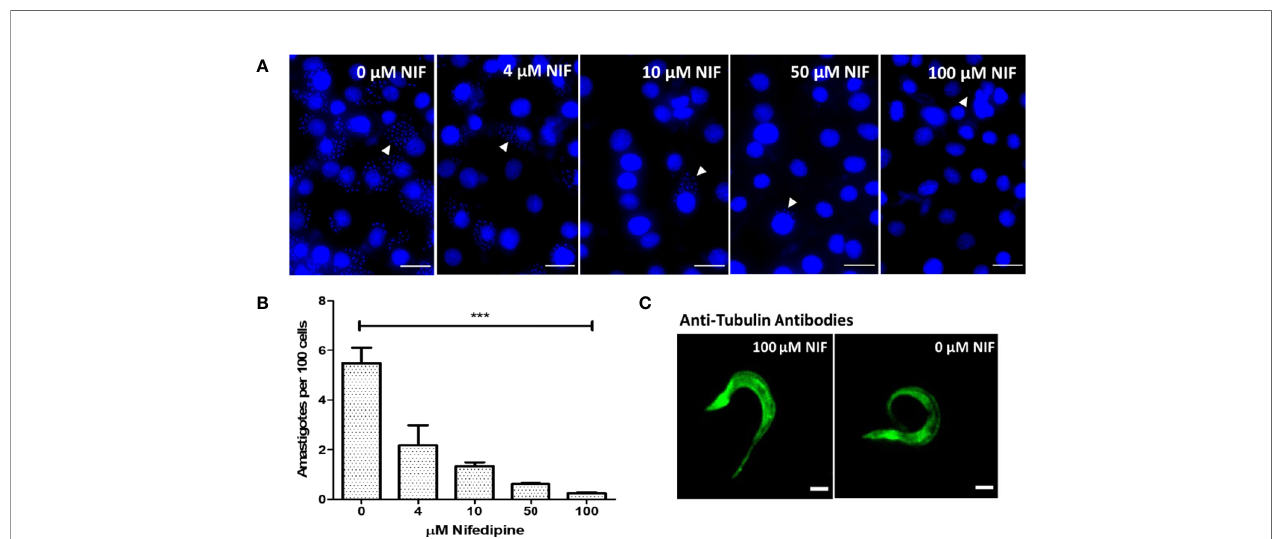
FIGURE 3 | Extracellular Ca 2+ uptake through Nifedipine- sensitive calcium channels is essential for tissue culture-derived trypomastigotes invasion. (A) Epithelial cells were incubated with trypomastigotes in the presence of 0, 4, 10, 50, and 100 µM Nifedipine (Nif) for 2 h and the infection analyzed 48 h later by the presence of intracellular T. cruzi amastigotes. White arrows indicate the amastigotes stained kinetoplasts; white bars represent 500 µm. (B) Quanti fi cation of 400 host cell infection from 3A. Statistical signi fi cance when compared with (0) (One-way ANOVA) P < 0.05. (C) Trypomastigotes incubated with 0 or 100 µM Nifedipine for 2 h, fi xed, and developed with anti-tubulin antibodies. White bars indicate 5 µm. ***P < 0.001.